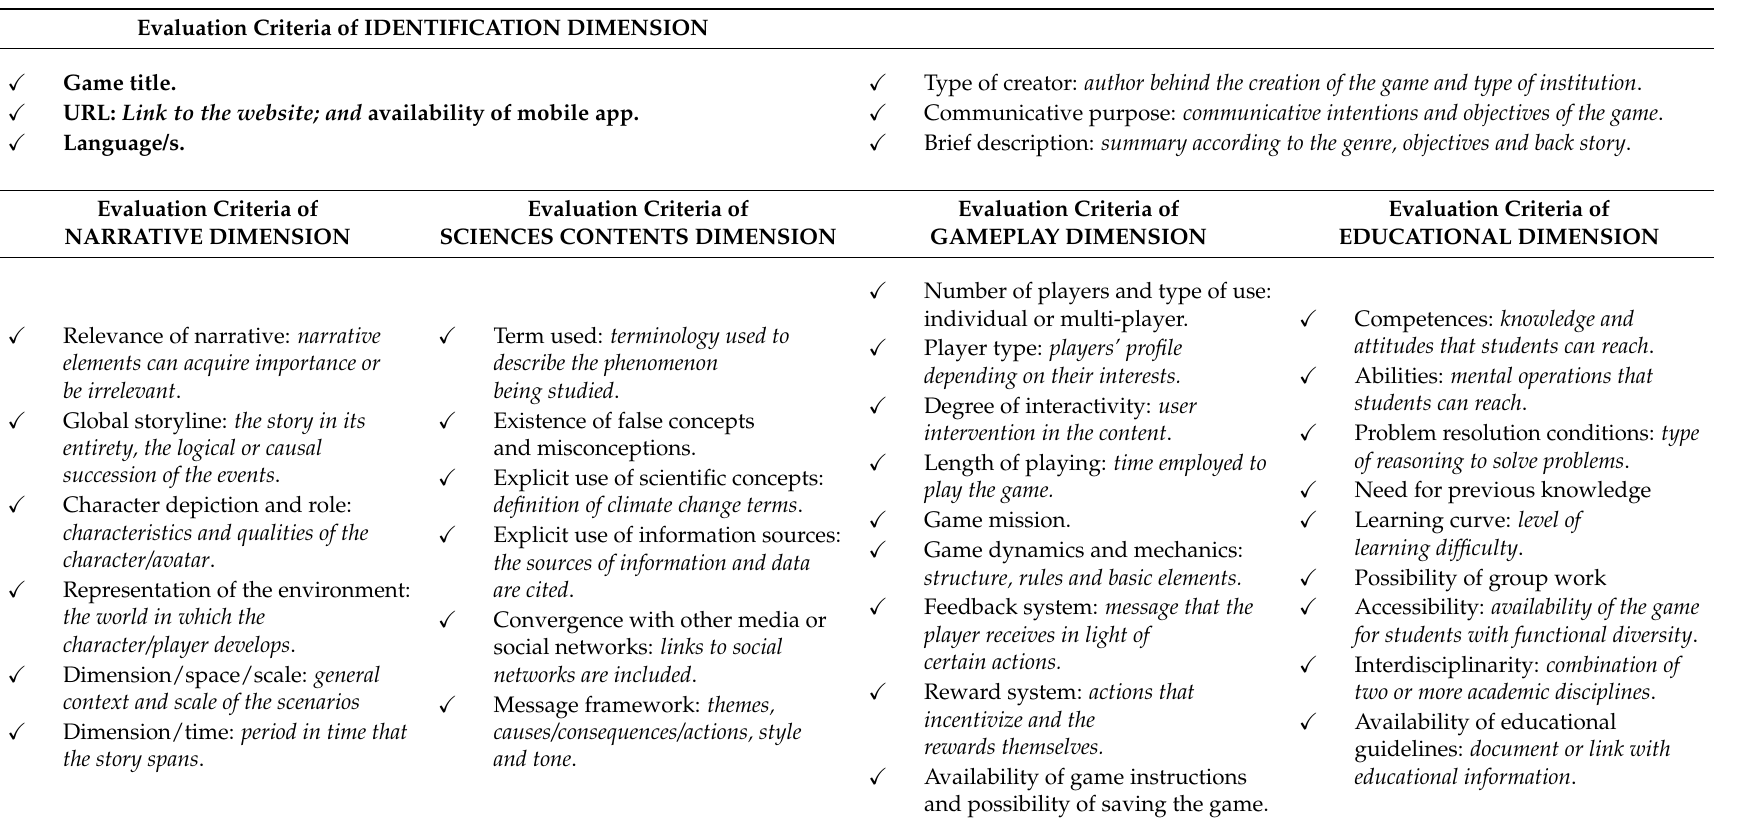
Table 2. Dimensions and evaluation criteria [adapted from